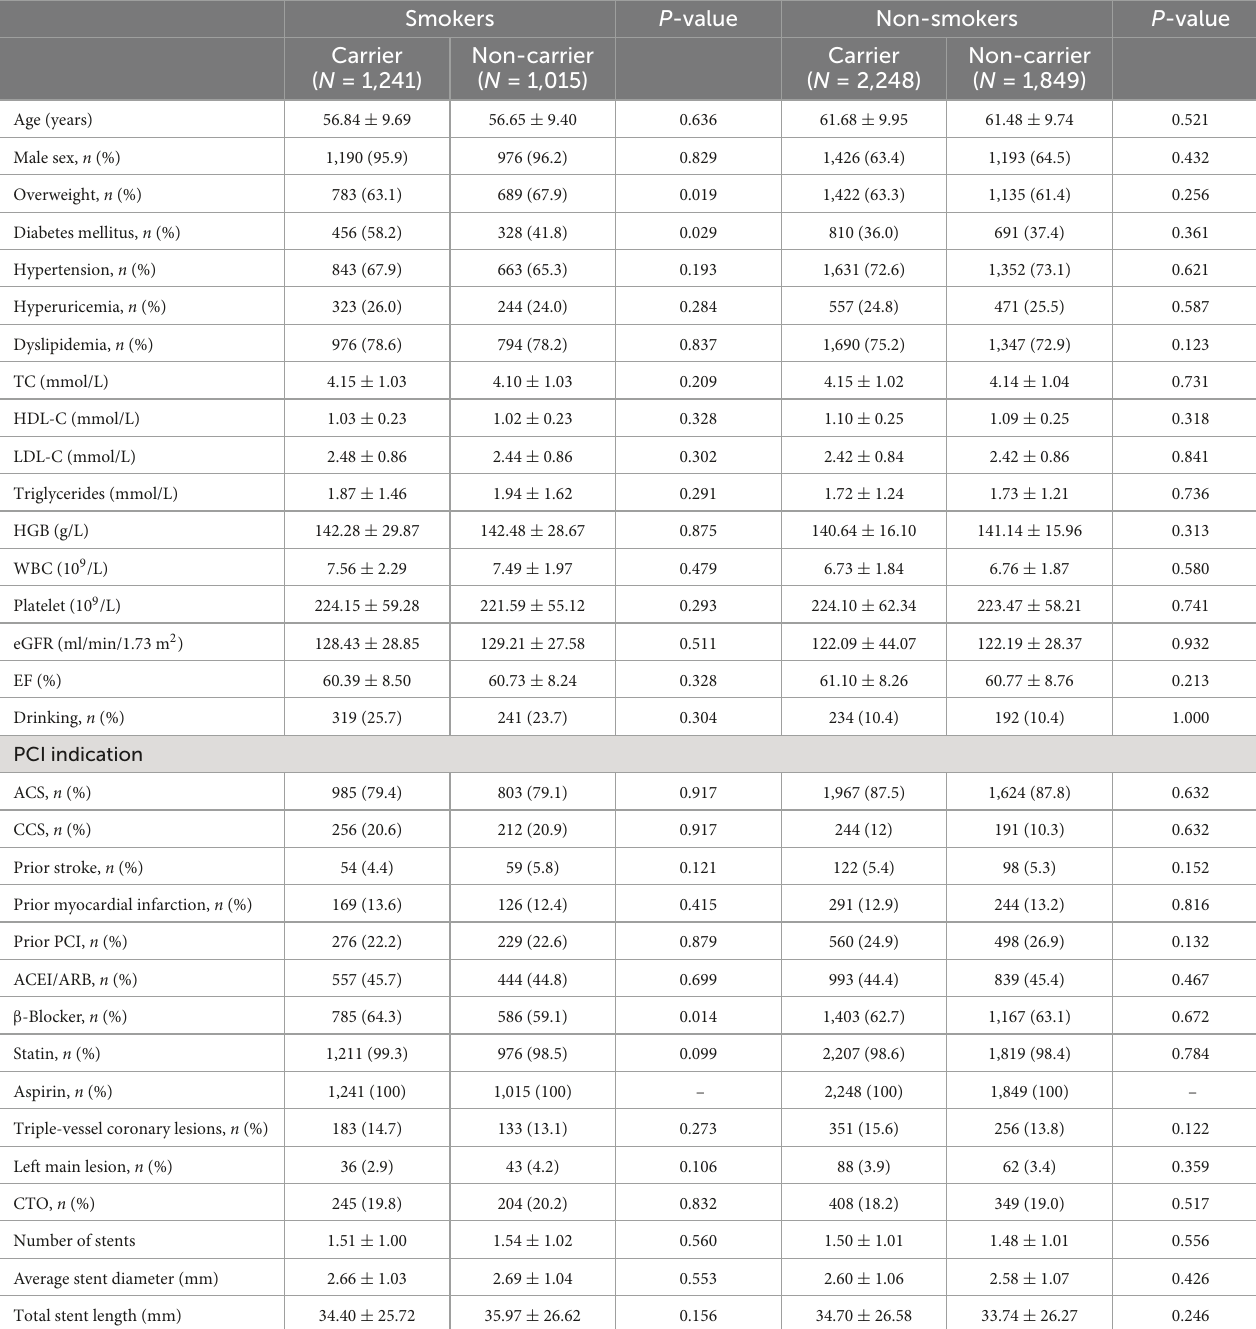
TABLE 2 Baseline characteristics of each patient with and without CYP2C19 loss-of-function alleles stratified by smoking status. Smokers P